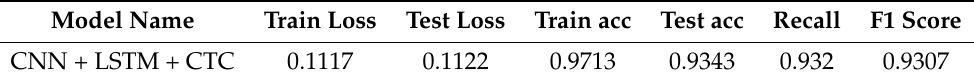
Table 5. Model metrics.